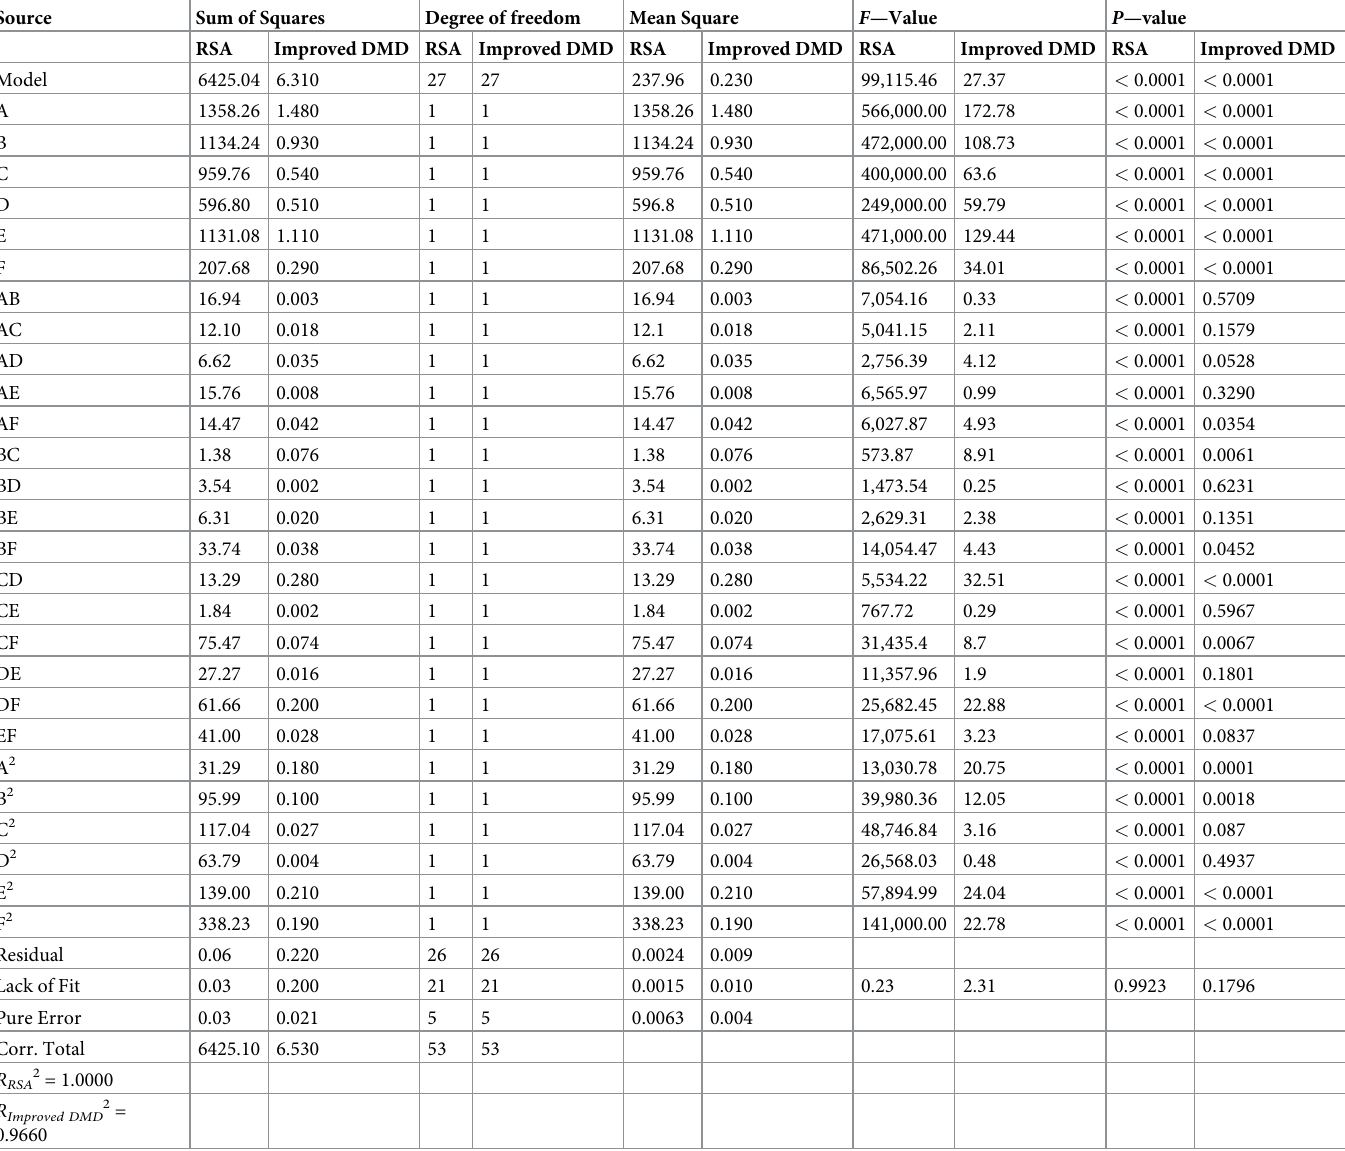
Table 6. ANOVA for the quadratic polynomial model for optimization of the exogenous carbohydrases zymogram for optimal RS and DMD in diets for broiler aged 1 to 3